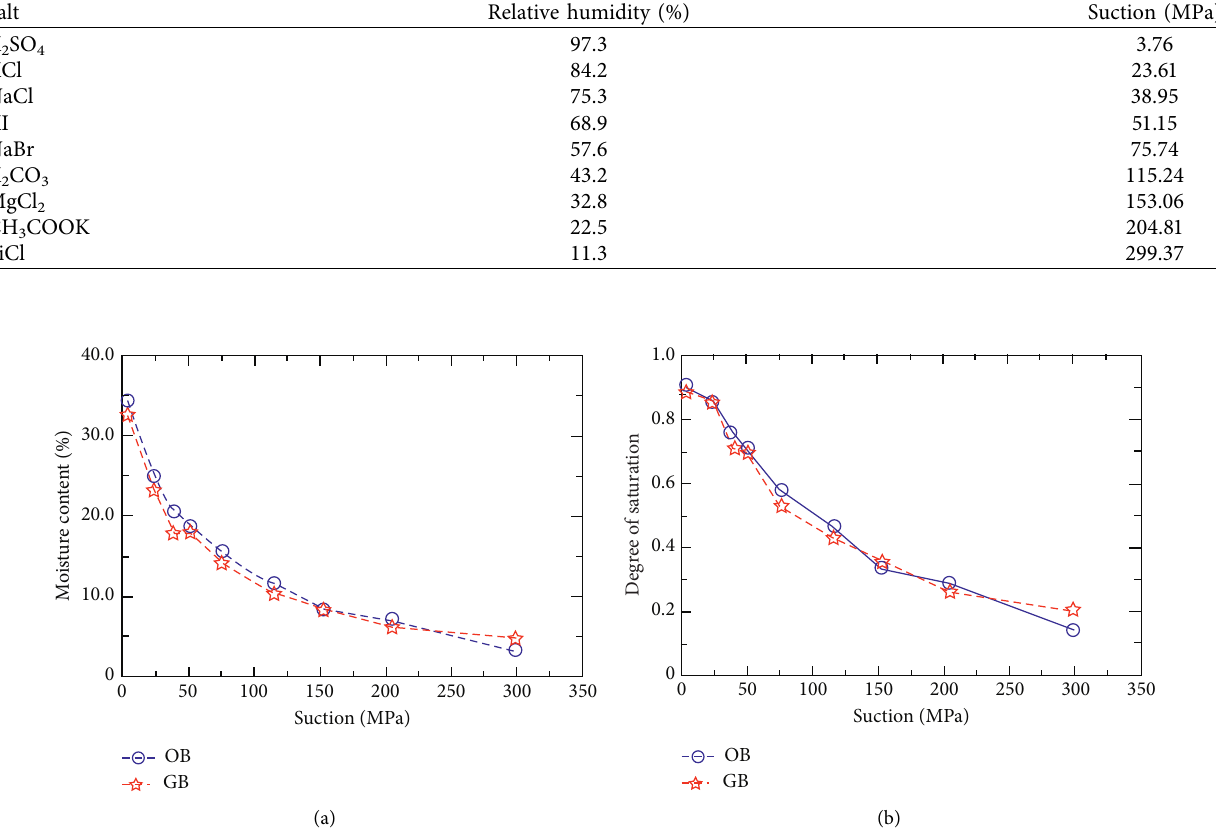
Figure 8: Water retention curves in the dehydrating process. (a) Moisture content against suction curves and (b) degree of saturation against suction